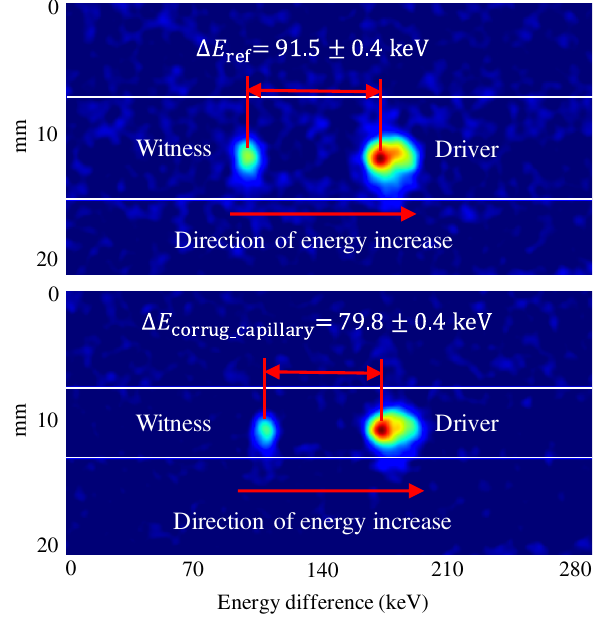
FIG. 5. CCD image of YAG screen.